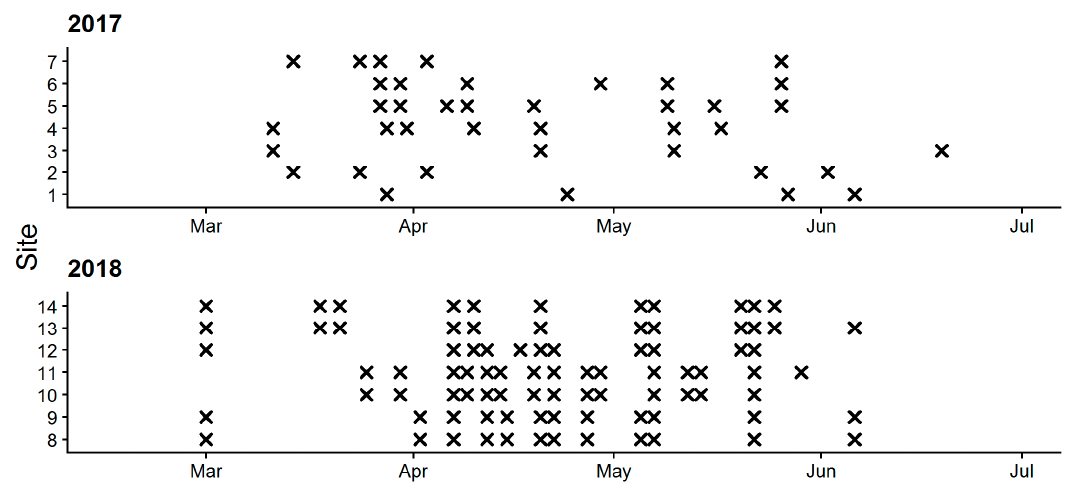
Figure 1. Data availability of Sentinel-2 imagery for study fields and the growing season 2016–2017 and 2017–2018. Every cross indicates one available image.